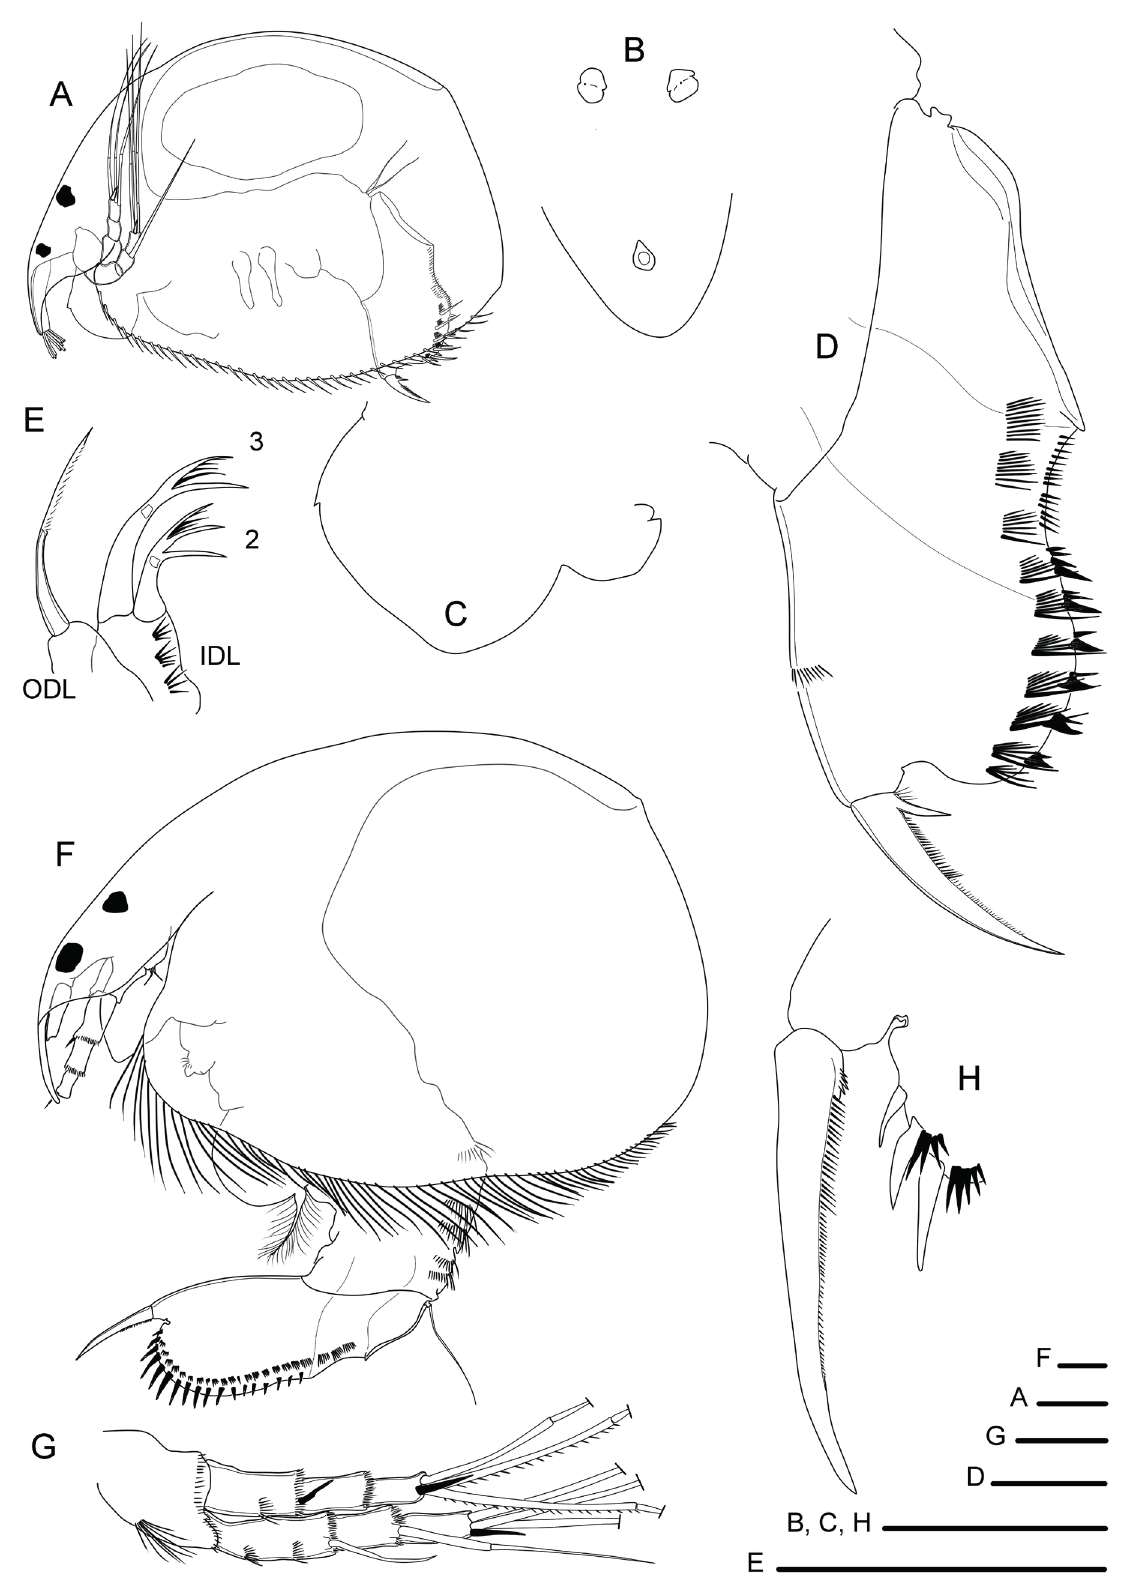
Figure 3. Parthenogenetic females from Lake Paranoá: A, Anthalona verrucosa verrucosa ; B, idem , main head pores; C, idem , labral keel; D, idem , postabdomen; E, idem , Inner Distal Lobe (IDL) of the first limb. F, Leydigiopsis ornata , G, idem , antenna; H, idem , postabdominal claw. Scale bars = 50